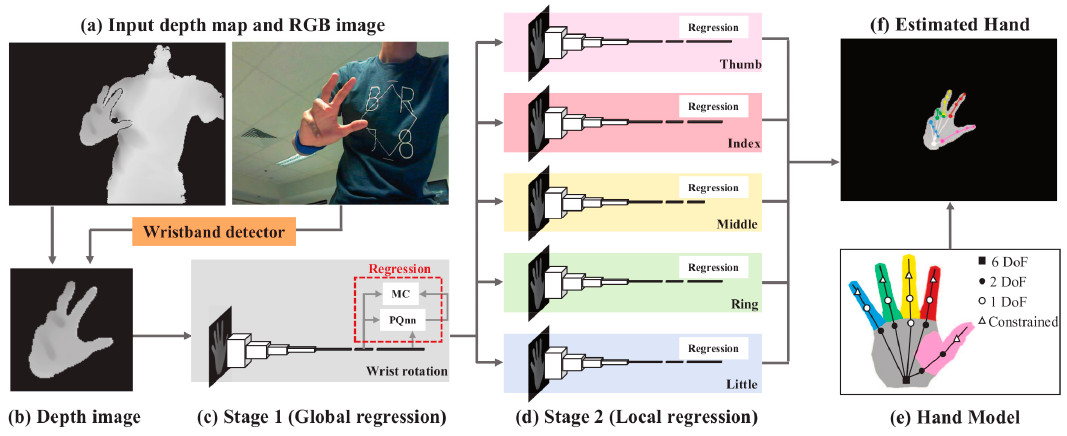
Figure 10. Global regression calculates the wrist parameters, local regression calculates five fingers parameters [20].